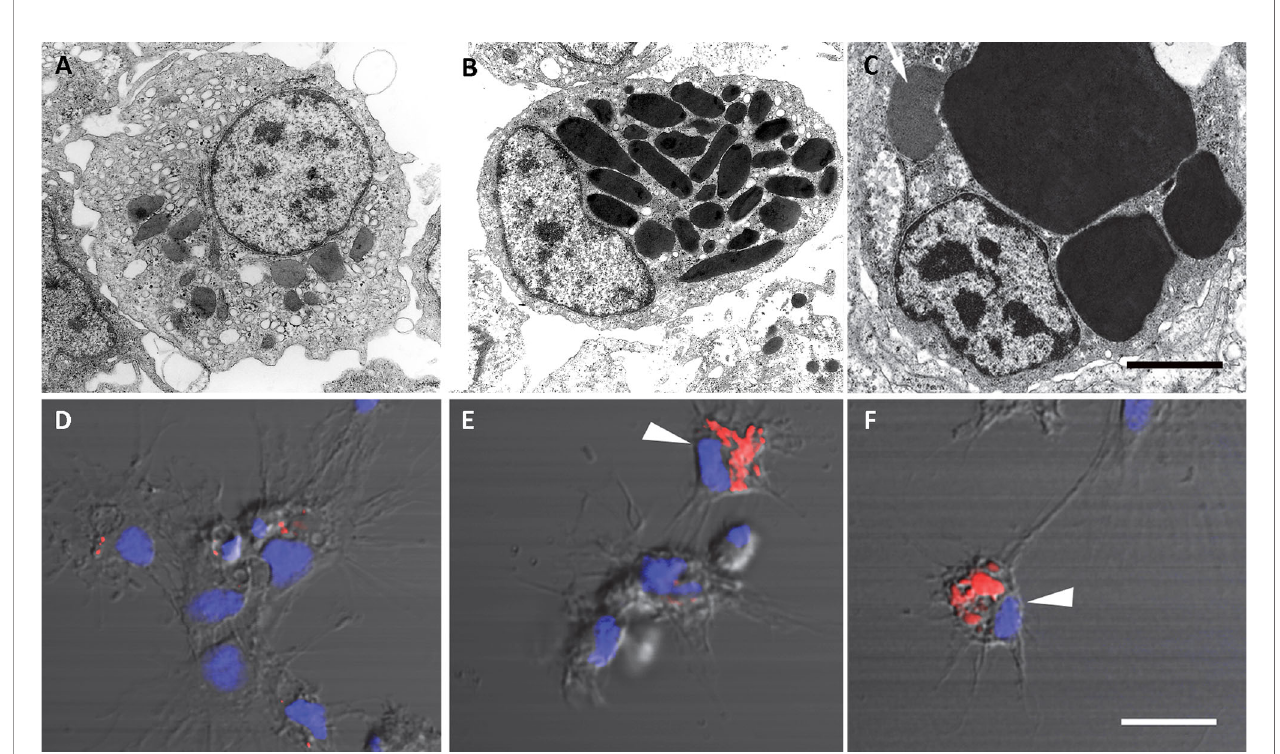
FIGURE 2 | Circulating hemocytes of P. canaliculata . Panels (A – C) , TEM; scale bar represents 1 m m. (A) Hyalinocyte with an eccentric nucleus, numerous SER vesicles, mitochondria and L granules; a few pro fi les of the RER are also seen. (B) Granulocyte, showing a displaced, bean-shaped nucleus and numerous R granules; some SER vesicles are also seen. (C) Granulocyte in a preparation exposed to E. coli cells showing extensive R granule fusion and a single L granule (arrow). Panels (D – F) , laser confocal microscopy, LysoTracker Red-Hoechst 33258 staining; scale bar represents 10 m m. (D) A group of spreading hyalinocytes; small acidic L granules (red) are seen in some of them. (E) A spreading granulocyte (arrowhead) showing numerous rod-shaped, acidic granules; also, there is a group of spreading and round hyalinocytes, which are essentially devoid of acidic granules. (F) Another spreading granulocyte (arrowhead) showing large and merging acidic granules; also, there are two spreading hyalinocytes with no acidic granules. Micrographs from